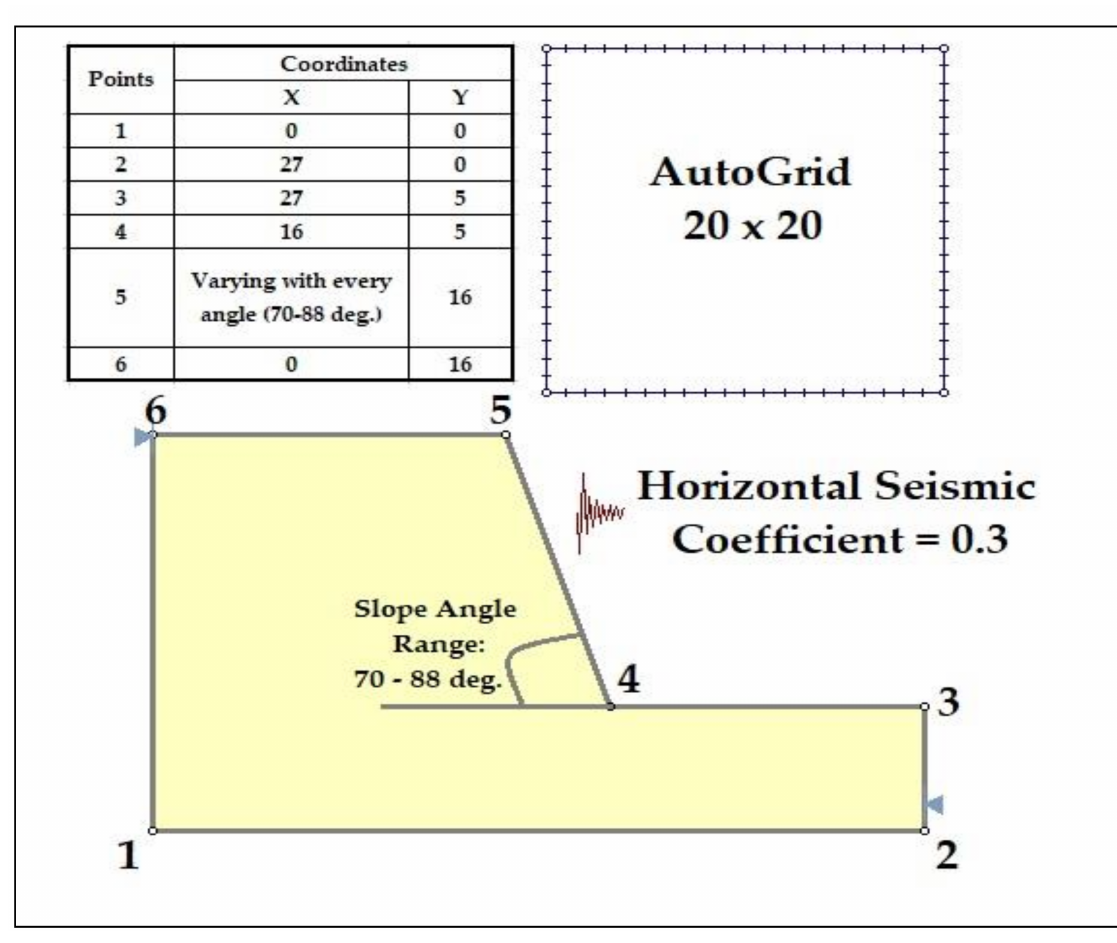
Figure 3. Slope model with coordinates.